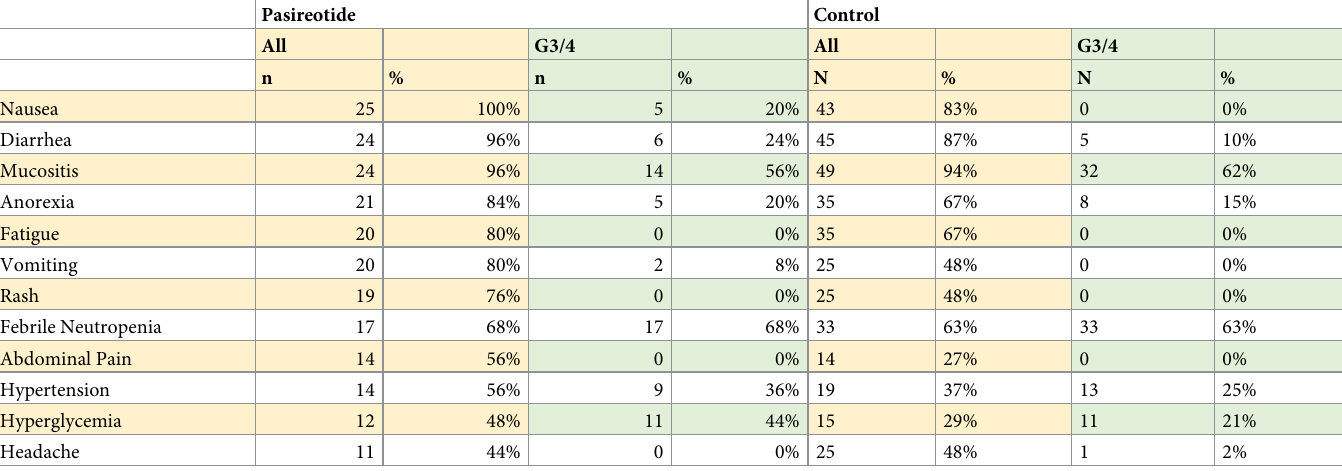
Table 4. Toxicities that occurred in > 40 percent of patients; percentages adjusted for missing values.